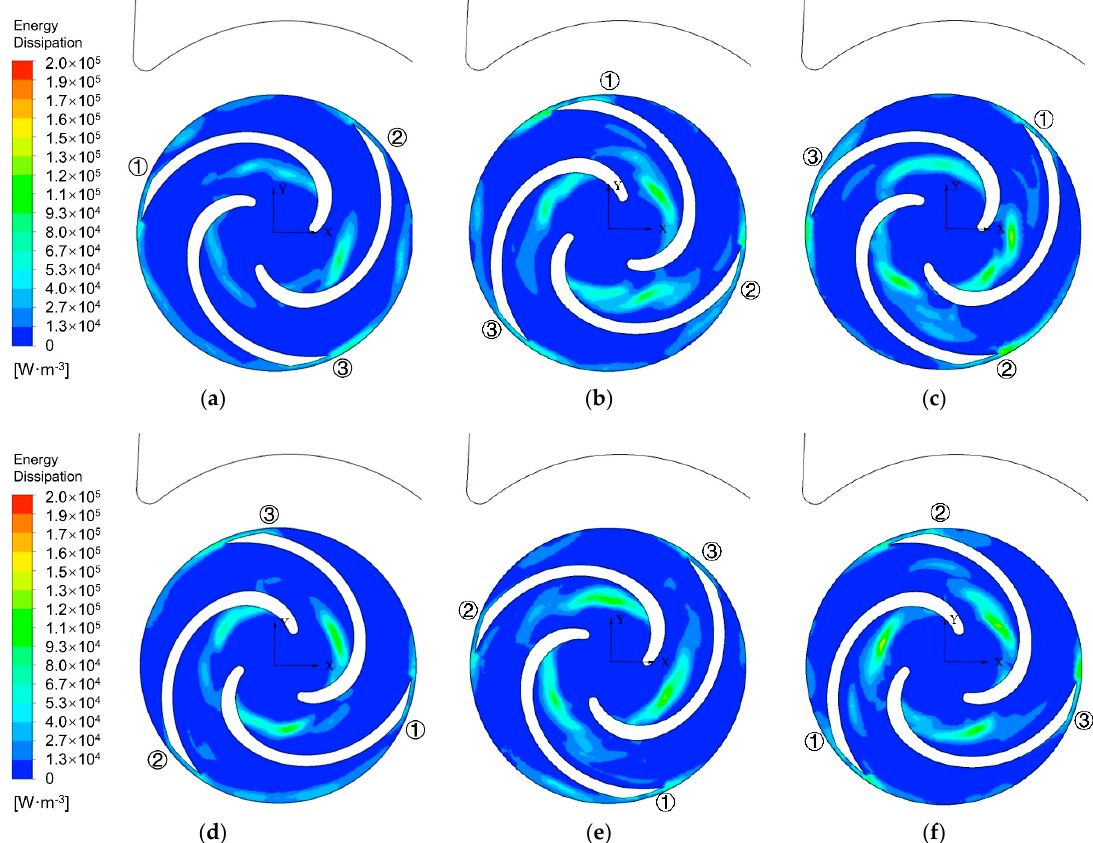
Figure 12. Internal energy dissipation rate on the cross-section A at six different moments at 0.5 × Q 0 operating condition. ( a ) t = 0.84 s (0°); ( b ) t = 0.85 s (60°); ( c ) t = 0.86 s (120°); ( d ) t = 0.87 s (180°); ( e ) t = 0.88 s (240°); ( f ) t = 0.89 s (300°).